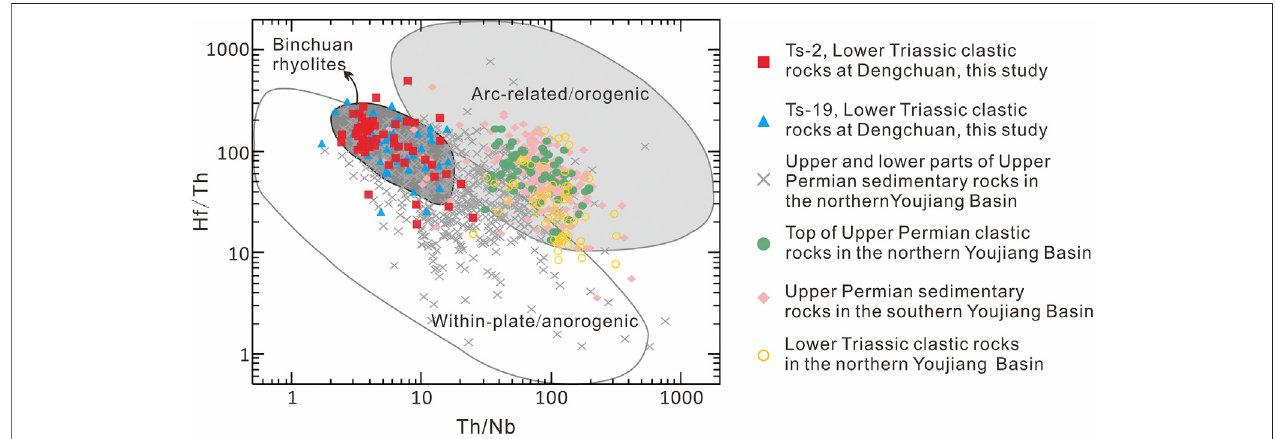
FIGURE9 | Th/Nb vs. Hf/Th diagram for zircons with ages of ~260 Ma from Lower Triassic clastic samples at Dengchuan (Yang et al., 2012). Zircon trace element datafortheupperandlowerpartsofUpperPermiansedimentaryrocksinthenorthernYoujiangBasin(Yangetal.,2012,2014,2015;Huangetal.,2014;Yuetal.,2016), the top of Upper Permian clastic rocks in the northern Youjiang Basin (Yang et al., 2012), Upper Permian sedimentary rocks in the southern Youjiang Basin (Yu et al., 2016), and Lower Triassic clastic rocks in the northern Youjiang Basin are shown for comparison (Yang et al., 2012, 2014).